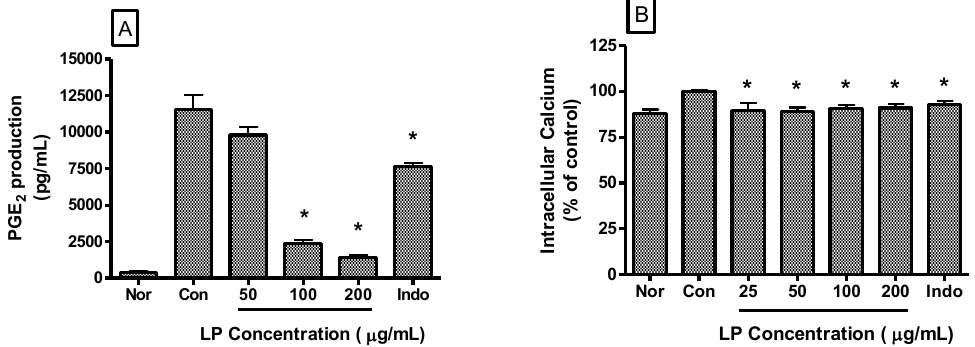
Figure 4. Effects of LP on PGE2 production ( A ) and calcium release ( B ) in LPS-stimulated RAW 264.7 macrophages. PGE2 concentrations in the culture medium were measured after 24 h incubation by a PGE2 parameter assay. And, intracellular calcium release was measured after 30 min incubation by Fluo-4 assay. Normal group (Nor) was treated with medium only. Control group (Con) was treated with LPS (1 μg/mL) alone. Indo denotes indomethacin (0.5 μM) with LPS. Values are the mean ± SEM of three independent experiments. * p < 0.05 vs. Con.